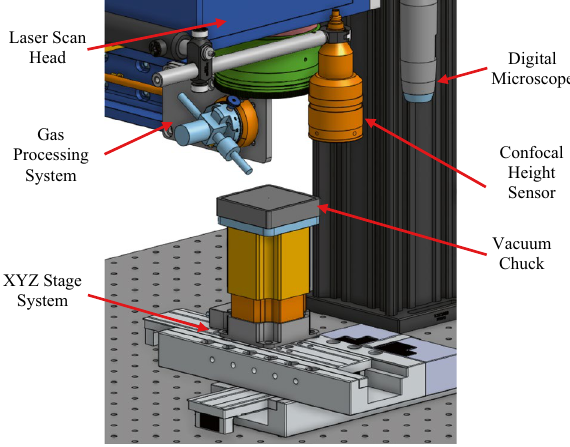
Figure 5. 3D CAD design of the laser system.